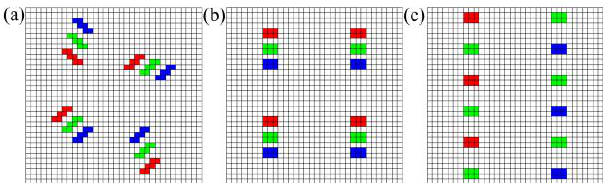
Figure 3. Partial areas of sampling patterns containing 12 sampling points: ( a ) Multi-hyperuniform sampling pattern; ( b ) Regular sampling pattern; ( c ) Bayer sampling pattern.